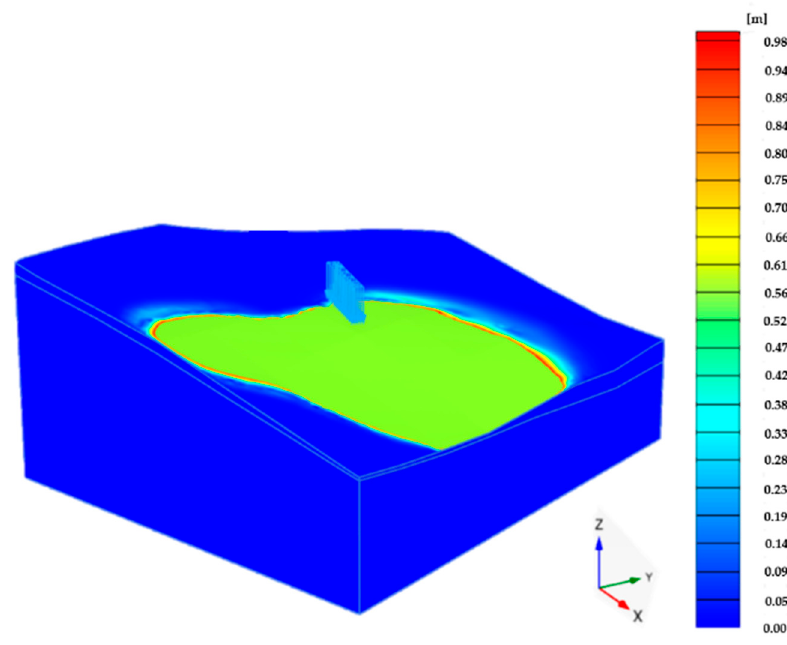
Figure 13. Safety analysis results after the groundwater level rise (SF = 1.279).